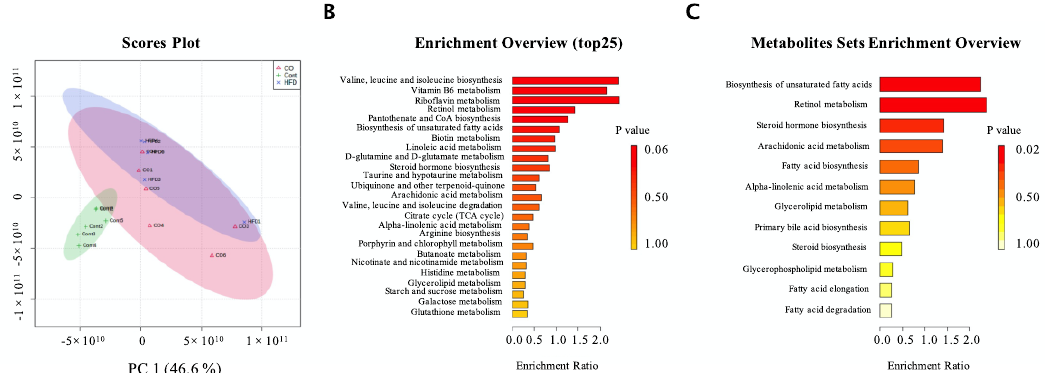
Figure 4. Metabolic phenotype of serum in mice. ( A ) Principal component analysis (PCA) showed differences in metabolites of serum samples in mice between the control, the HFD group, and the CO group. The green area represents the cumulative from the control mice, the pink circle exhibits the cumulative metabolites belonging to the HFD group, and the purple area shows the cumulative metabolites in CO treatment mice; ( B ) Metabolic pathway enrichment analysis. Overview of metabolites that were enriched in mice among three groups; ( C ) Metabolic pathway related to lipid enrichment analysis. Overview of metabolites related to lipid that was enriched in mice among three groups. Each dietary group comprised n = 6 mice.